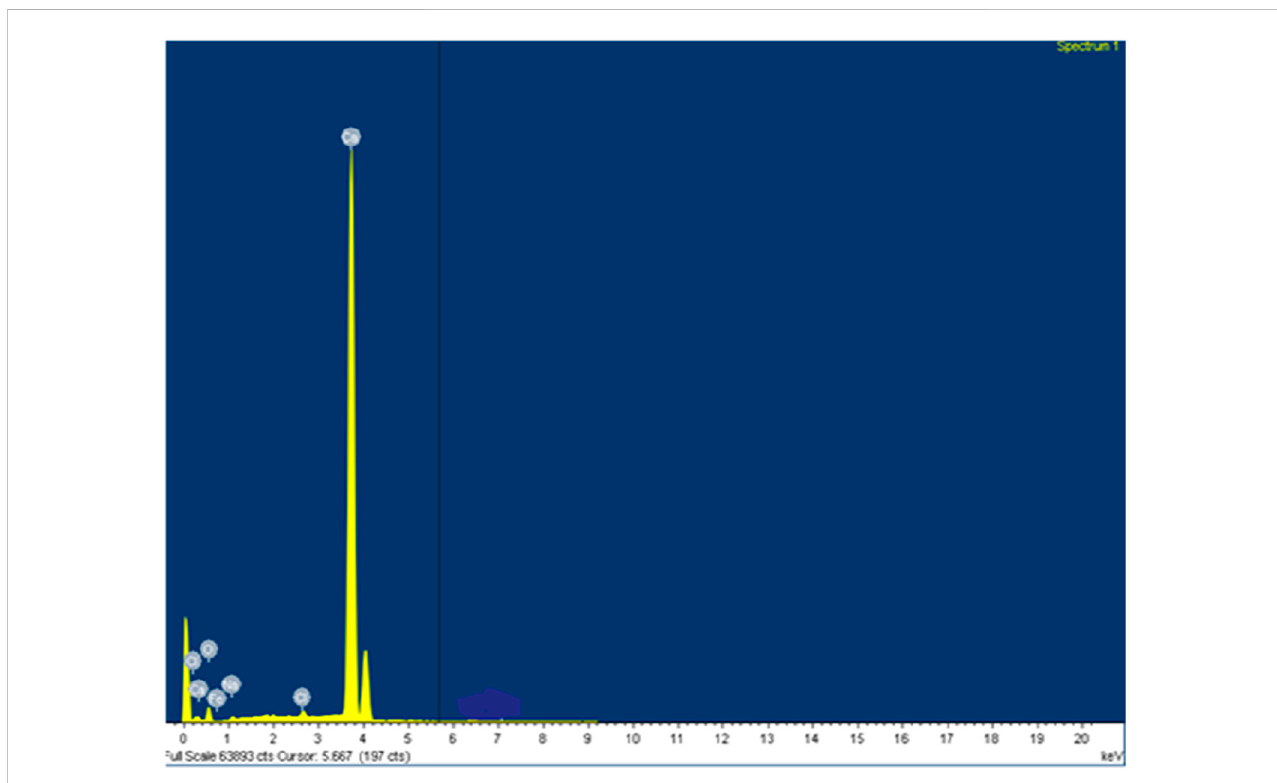
EDS image of calcined cuttle fi sh